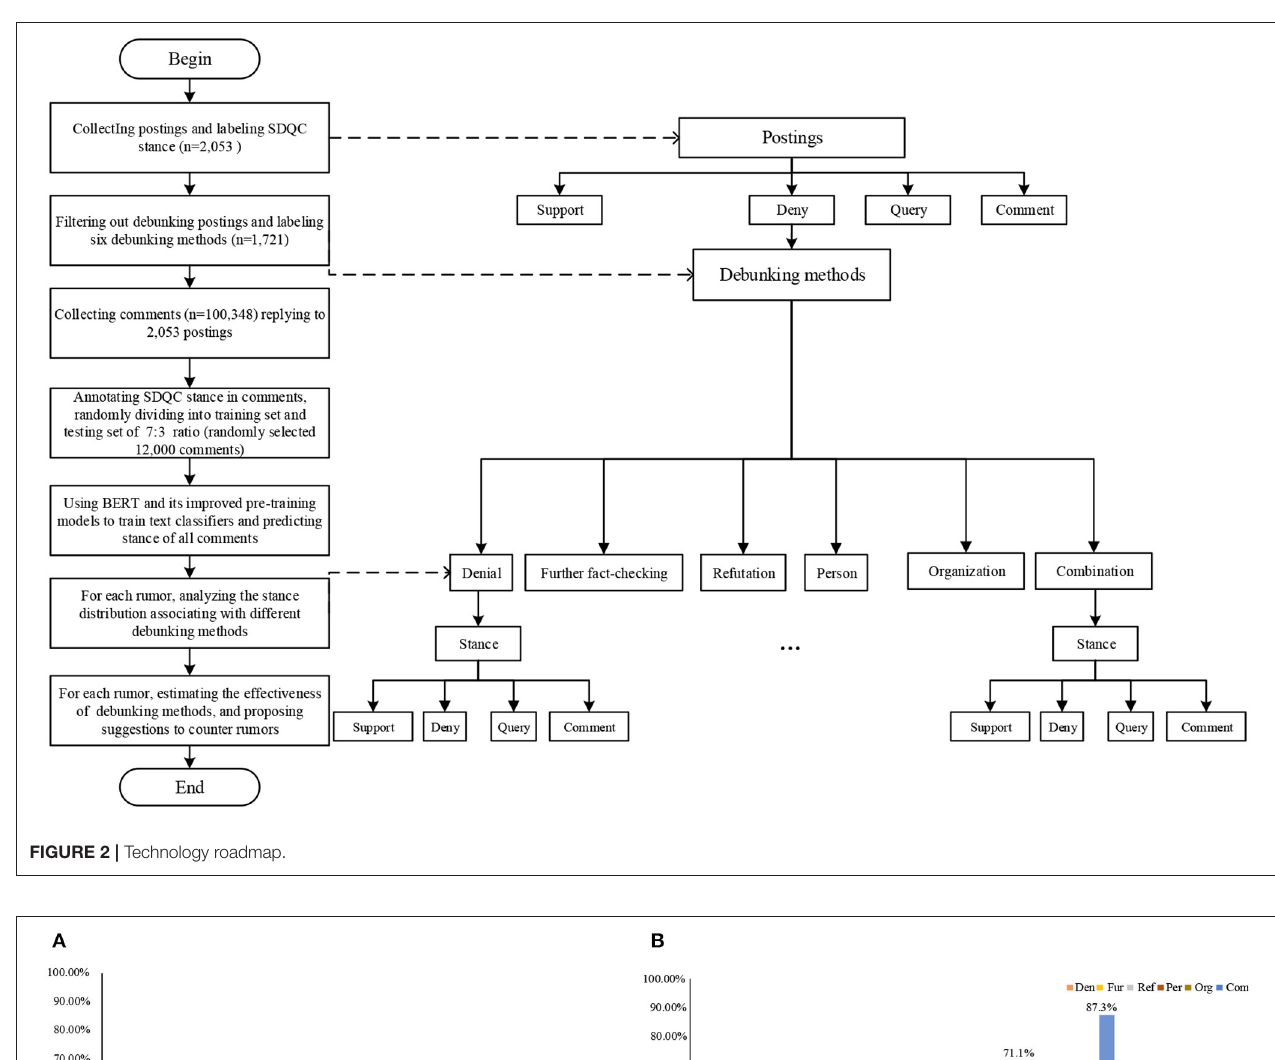
FIGURE 2 | Technology roadmap.